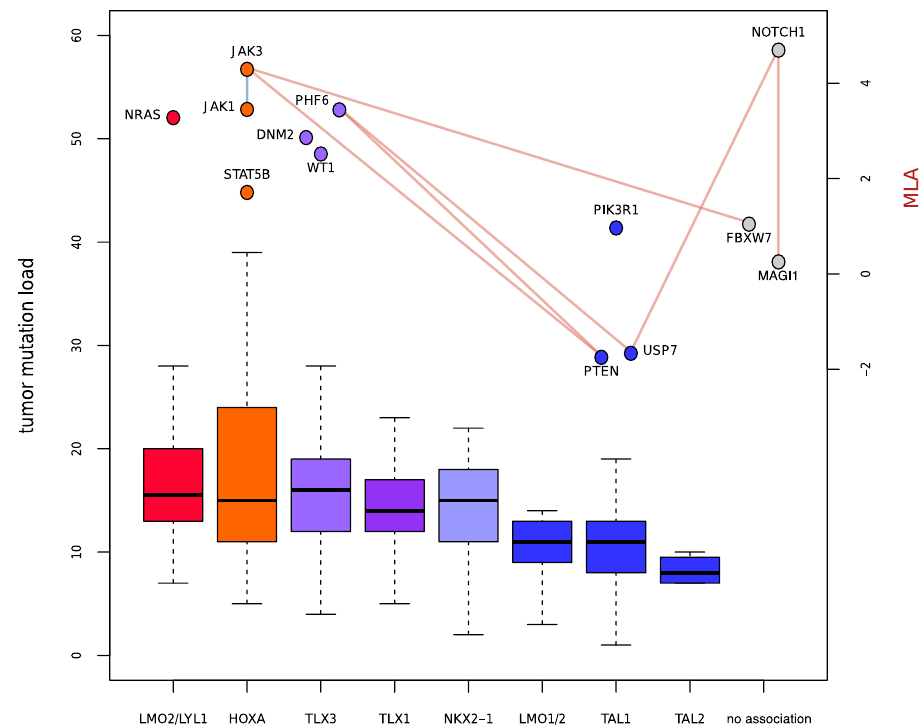
Fig. 5 Tumor mutation load is lower in more mature T-ALL subtypes. Sample tumor mutation load for each T-all subtype, with subtypes ordered (left to right) from early to late T-cell progenitor stage. Genes that were part of a candidate genetic interaction and that were signi fi cantly associated with a T-ALL subtype are depicted in the fi gure with their corresponding subtype and their MLA score (secondary vertical axis). Subtype ordering, coloring and assignment to genes were reproduced from Fig. 3 in ref. 31 . Edges between genes represent “ suspect ” candidate genetic interactions found in T-ALL, de fi ned as mutually exclusive gene pairs (shown in red) with one gene having an MLA score > 3 and together having a difference in MLA score > 3 or a co- occurring pair (shown in blue) with both genes having an MLA > 3. Source data underlying Fig. 5 can be found in Supplementary Data